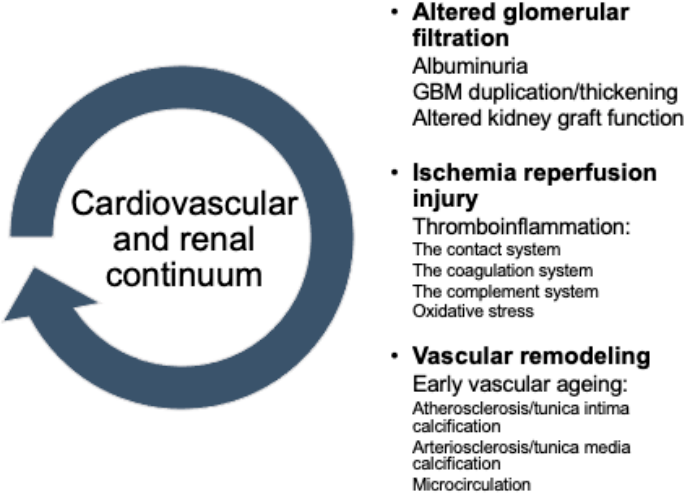
Figure 1. Proposed pathways for impaired cardiorenal continuum after kidney transplantation in kidney transplant recipient.